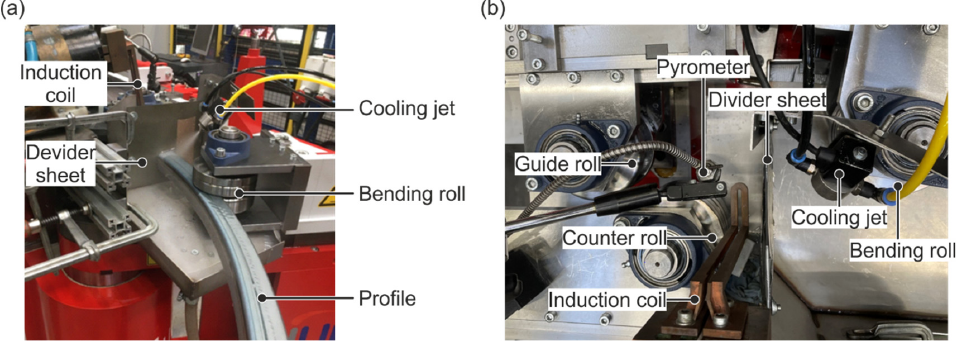
Figure 3. Experimental setup, ( a ) frontal view, ( b ) top view between the rolls. L-profiles with a width b of 40 mm and a thickness t of 2.5 mm are analyzed. The loaded bending radius is set to 600 mm. The profile feed velocity is varied between 4 mm/s and 8 mm/s to show the influence of feed velocity on springback. The temperatures for the partial heating of a single profile area are room temperature and varying temperatures between 200 °C to 600 °C in 100 °C steps. Higher temperatures are not investigated as material recrystallization mechanisms are not considered in this work. The term partial heating always refers to the heating of the area of the L-profile parallel to the force as depicted in Figure